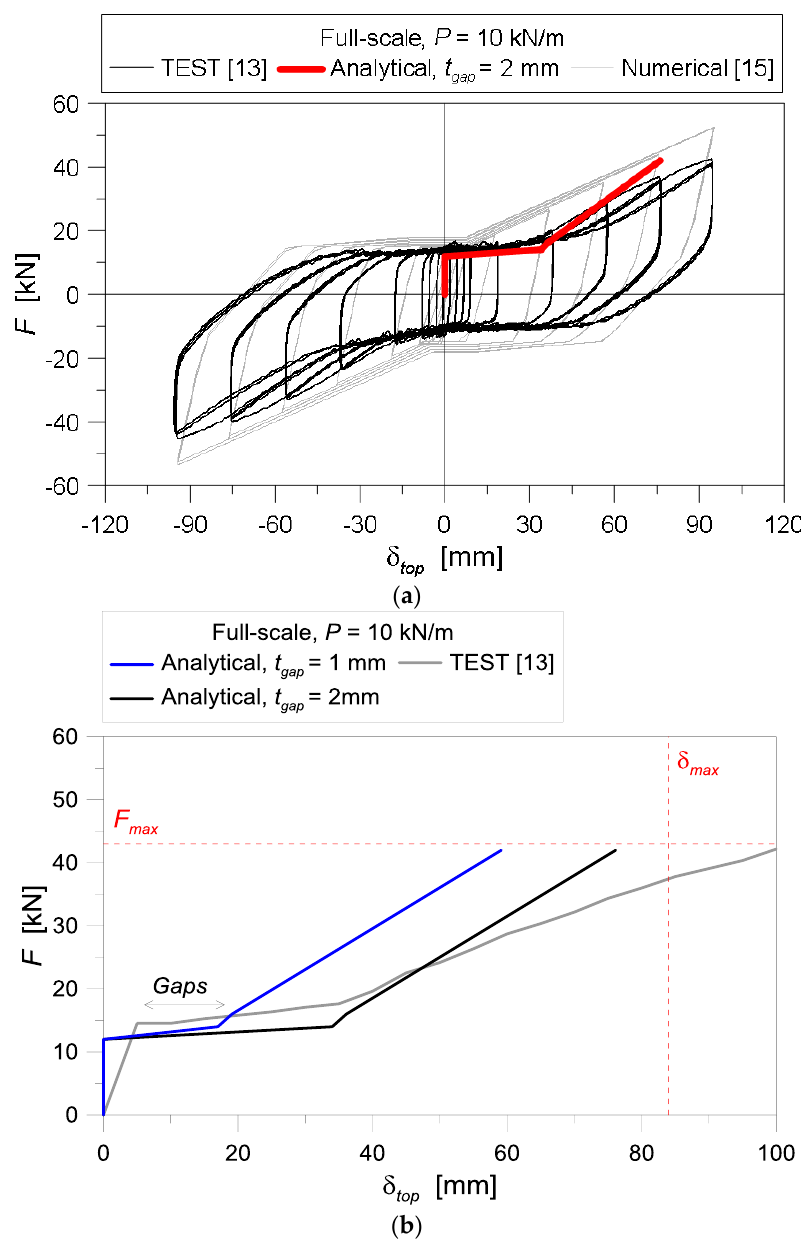
Figure 11. Comparison between the analytical model predictions, the past test results [12,13] and the refined FE model presented in Reference [15] for full-scale log-house walls. ( a ) Cyclic and ( b ) monotonic performance assessment of the “M_ST_90” experimental sample ( L = 4.20 m, H = 2.80 m, p = 10 kN/m, Standard joints)